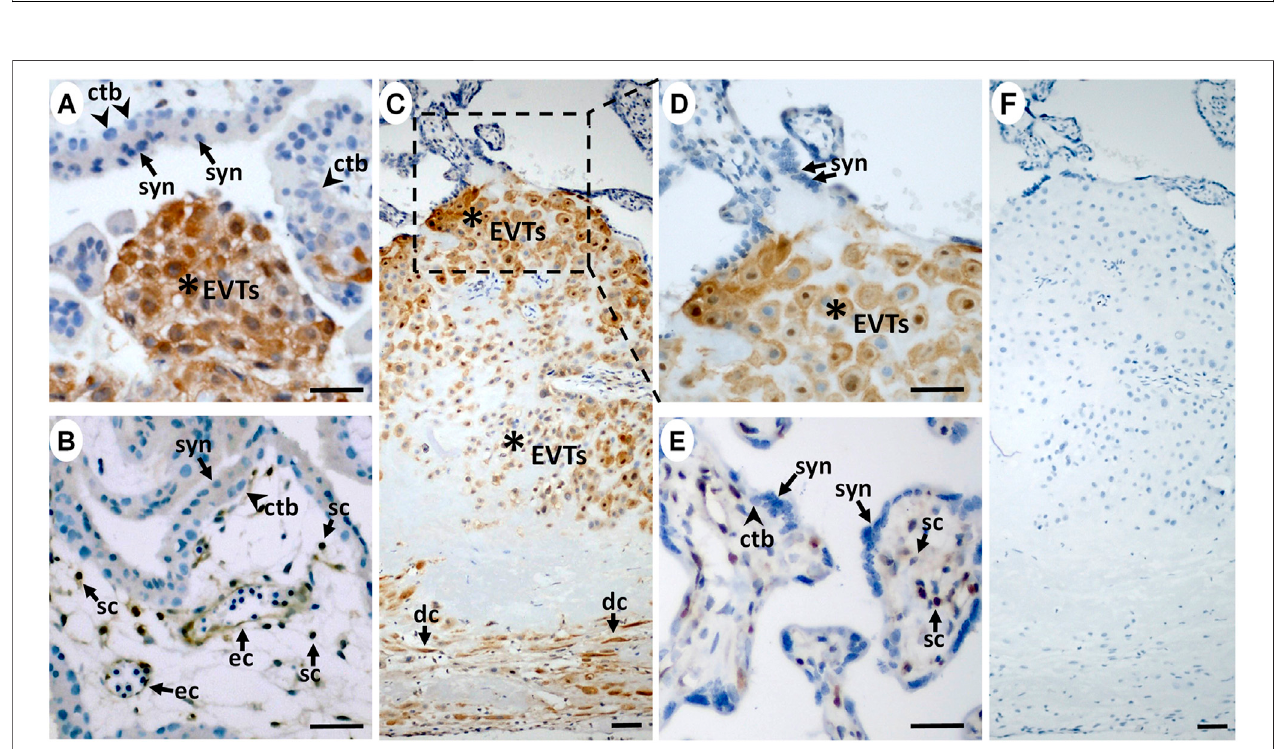
FIGURE 2 | ISG15 protein is preferentially expressed by extravillous trophoblasts during in vivo differentiation. In fi rst ( A,B ; n = 2) and third trimester ( C – E ; n = 11) placentas,immunoreactive ISG15 expressionwaspredominantlylimitedtoEVTs(stars)withamoderateexpressioninsomevillousstromalcells(sc)andendothelialcells (ec) in fi rst (B) and third trimester (E) placental samples. (C) Decidual cells (dc) were also positive for ISG15 immunoreactivity. (F) Negative control staining displayed no immunoreactivity. Scale bars = 30 µm. (syn = syncytiotrophoblast, ctb = cytotrophoblast).